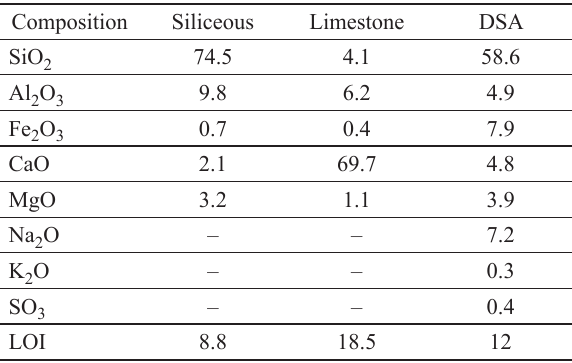
(SEM) pictures of the three additives tested. In this fig - ure the granular grading and regular geometry of DSA particles can be observed. Additionally, XRF testing was carried out on these additives and their major constituents were determined as reported in Table 2.